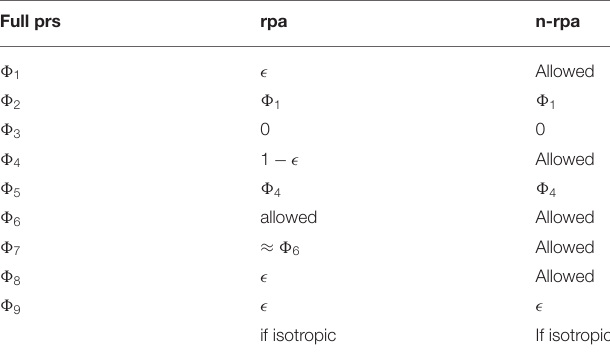
TABLE 1 | Values of parameters averaged over a full, periodically repeated surface (prs) if the random-phase approximation (rpa) is valid and when it is not valid